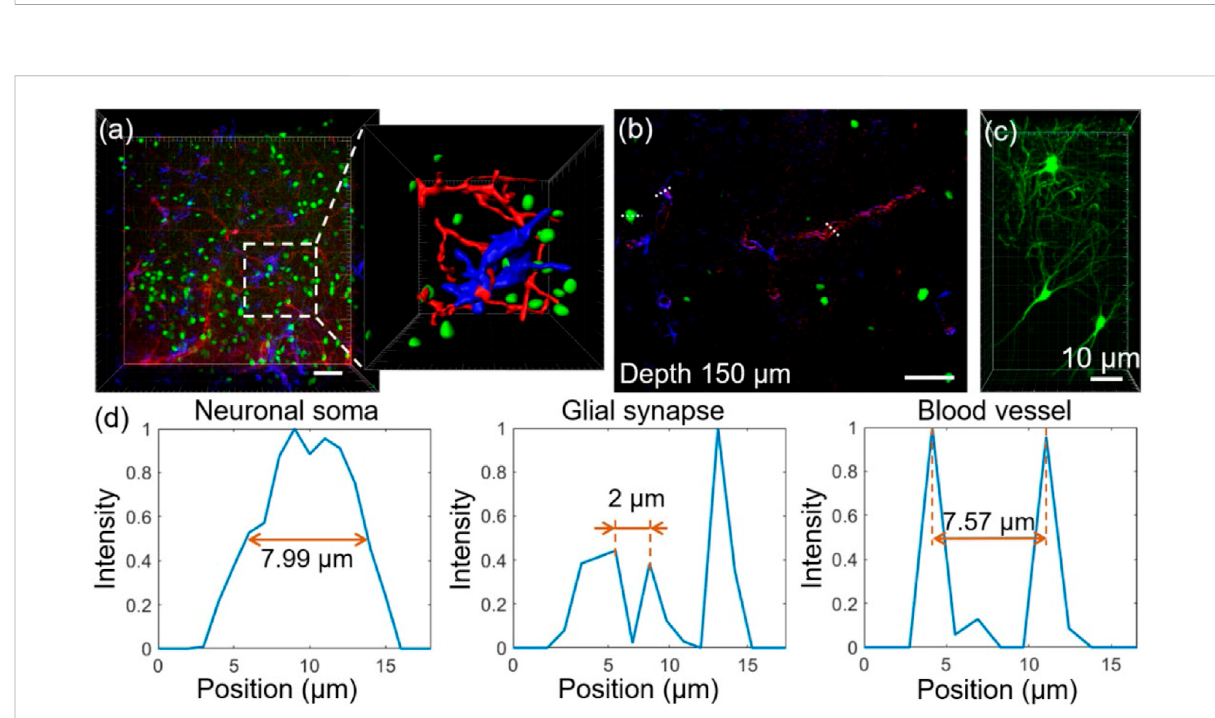
FIGURE 4 Fluorescence imaging quality after FOCMS. (A) Imaging of brain tissue with detailed structure exhibitionafter FOCMS clearing. Green: neurons, blue: glia cell, red: blood vessel. (B) Selected single imaging at the depth of 150 μ m in (A) . (C) Imaging of neurons with high NA objective lens. Scale bar:10 μ m (D) Normalized fl uorescencecorrespondingtotheneuronalSoma, glialsynapse,andbloodvesselatthedepthof150 μ min (B) indicated by the dashed line, respectively. Scale bar: 50 μ